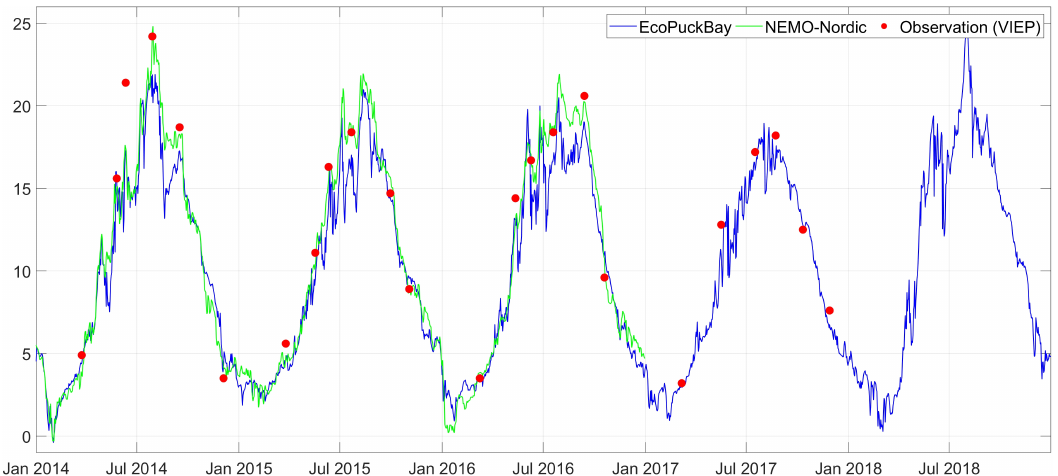
Figure A2. Time series of surface water temperature on station T11 compared with VIEP observations and NEMO-Nordic